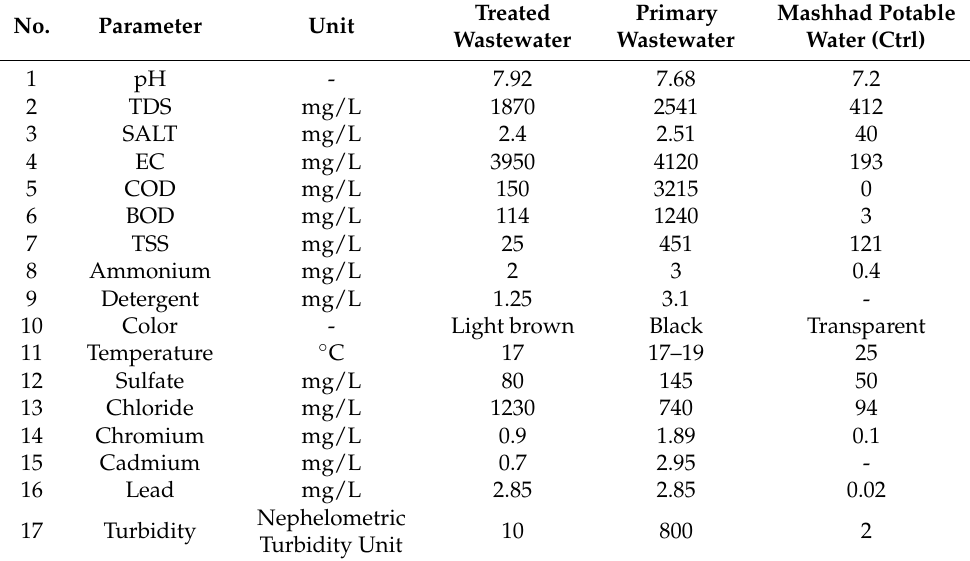
Table 2. Chemical and physical characteristics of treated wastewater and primary